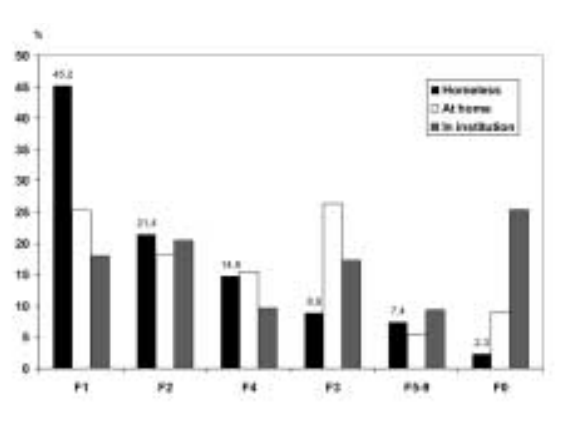
ICD-10 diagnoses among homeless inpatients.